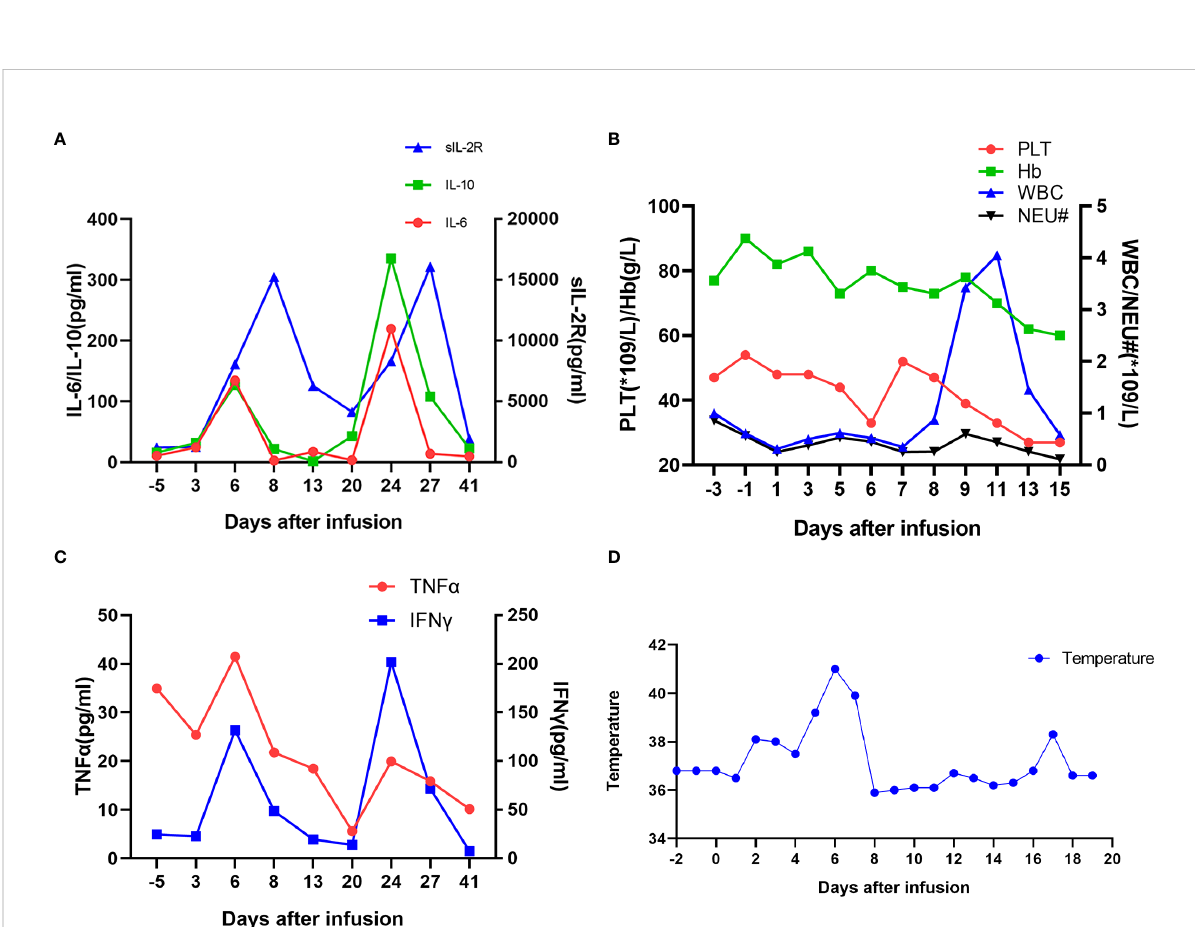
FIGURE 2 Measures of clinical responses to infusions of anti-BCMA CAR-T cells. (A) Concentrations of listed cytokines in serum obtained from the patient at the indicated time points. Day 0 is the day of anti-BCMA CAR-T cell infusion. (B) The results of blood routine tests and (C) serum TNF a and IFN g concentrations are shown at the indicated time points after anti-BCMA CAR-T cell infusion. (D) The plot shows the changes of the maximum temperature for each day after anti-BCMA CAR-T cell infusion.